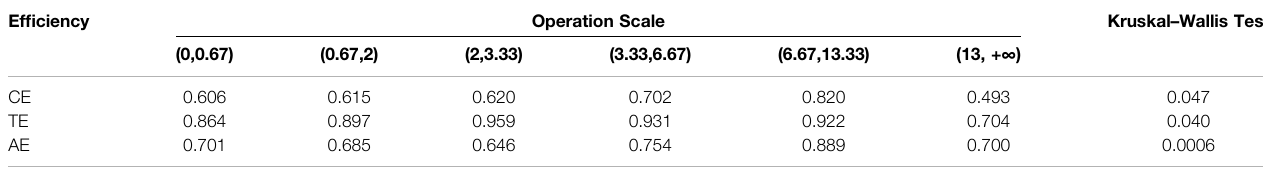
TABLE 2 | Cost ef fi ciency of rapeseed production at different